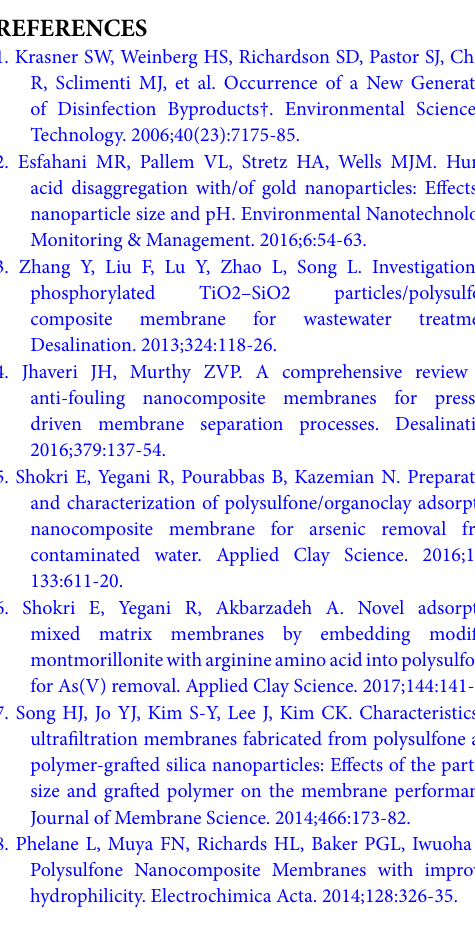
CONFLICTS OF INTEREST There are no conflicts to